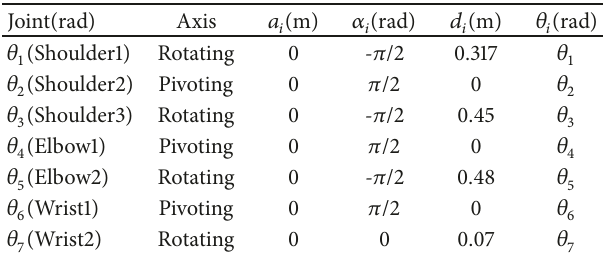
Table 1: D-H parameters of